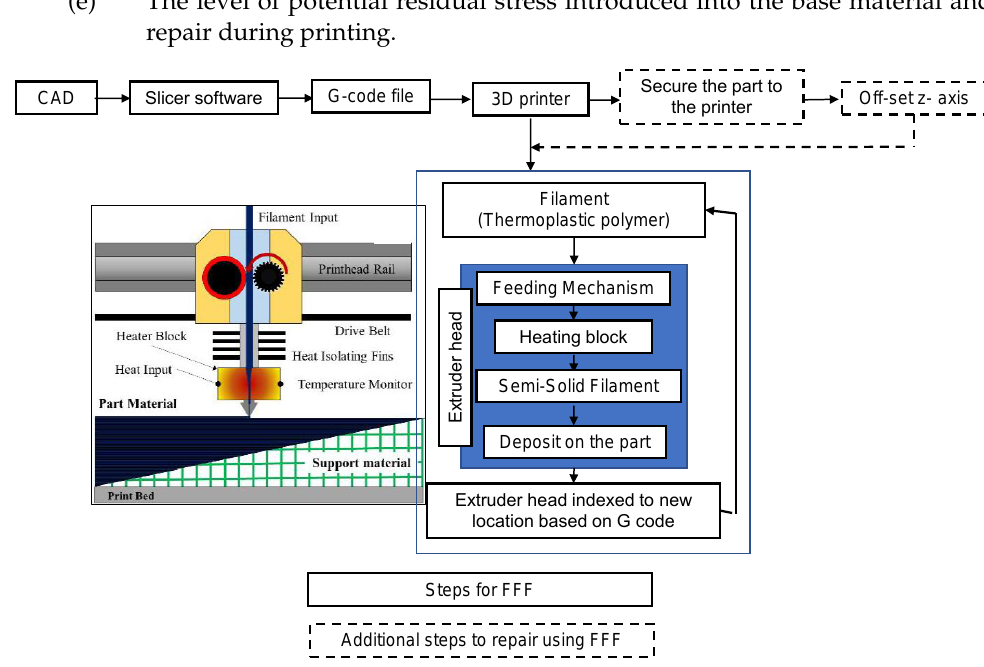
Figure 4. Steps to print a part using FFF and modification required to the traditional FFF process to repair a given part using FFF [49]. Figure reproduced under the terms of a CC-BY